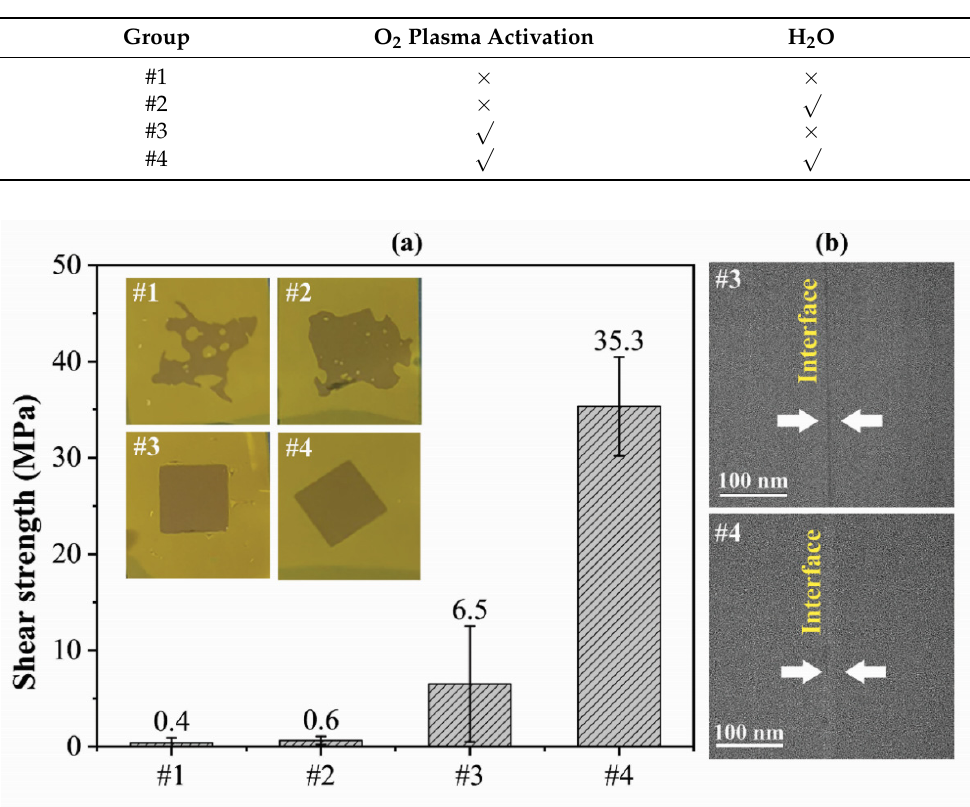
Table 1. Comparative tests with or without plasma activation and water molecules assisting.